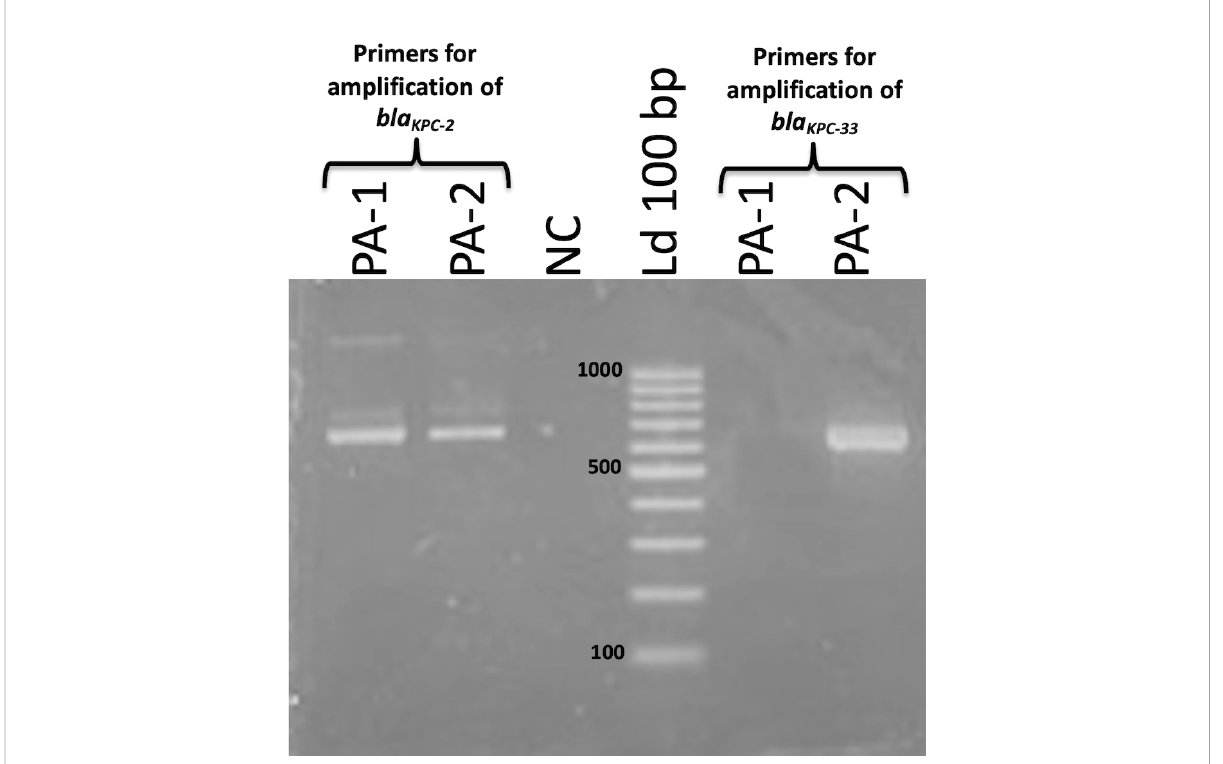
FIGURE 4 Agarose gel electrophoresis of PCR products obtained in the ampli fi cation of PA-1 and PA-2 DNA using primers for ampli fi cation of bla KPC-2 (left) and bla KPC-33 (right). Both primer pairs amplify a fragment of 640 bp. Band sizes (bp) of the Molecular Weight Standard (Ld 100 bp) are indicated next to the